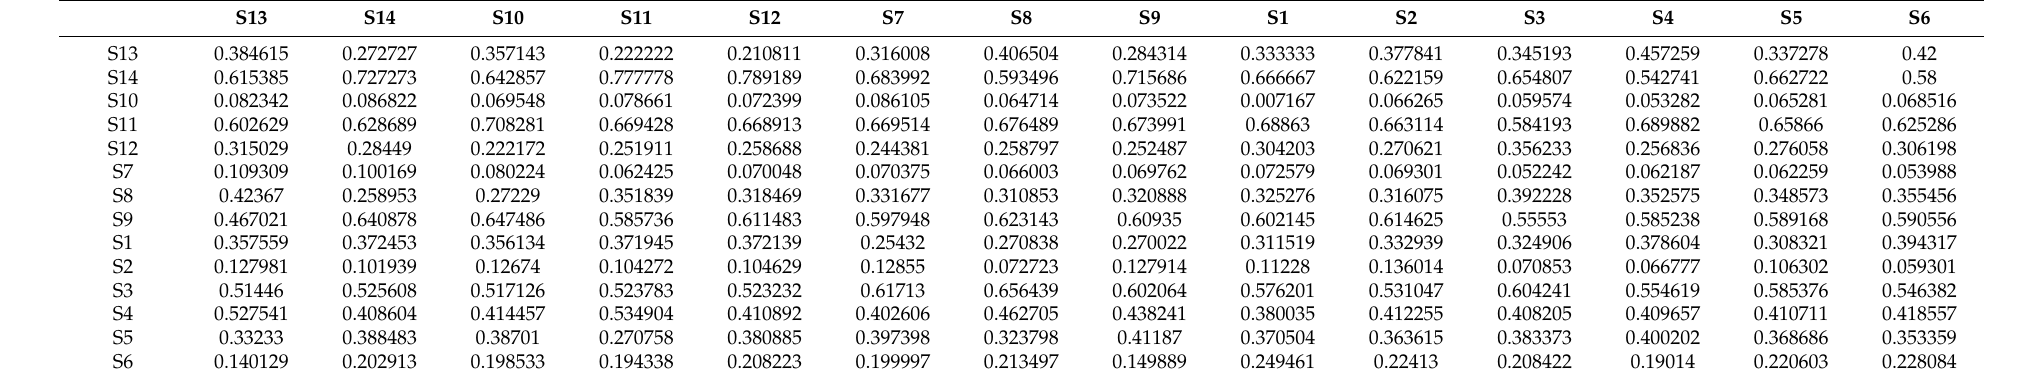
Table A1. Unweighted supermatrix for compatibility before the convergence of dimensions.